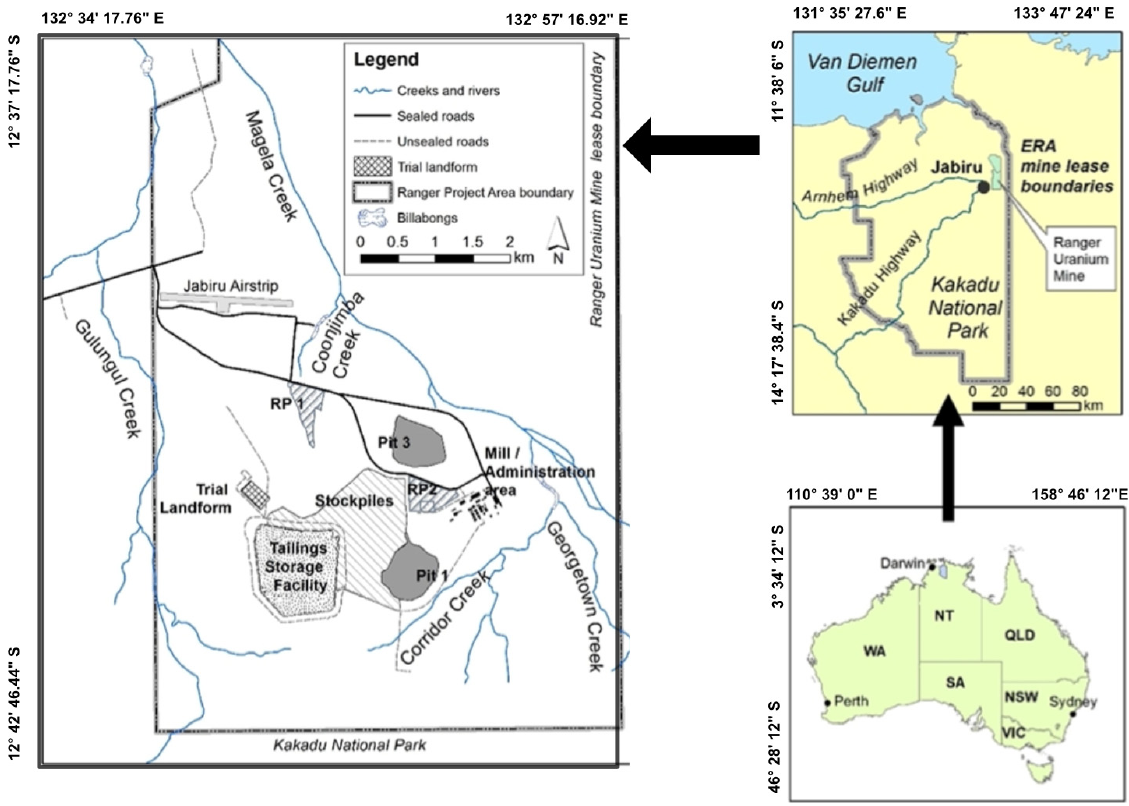
Figure 3. Location of Ranger Uranium Mine. Adapted from [40] and reproduced under Creative Commons CC by at- tribution.